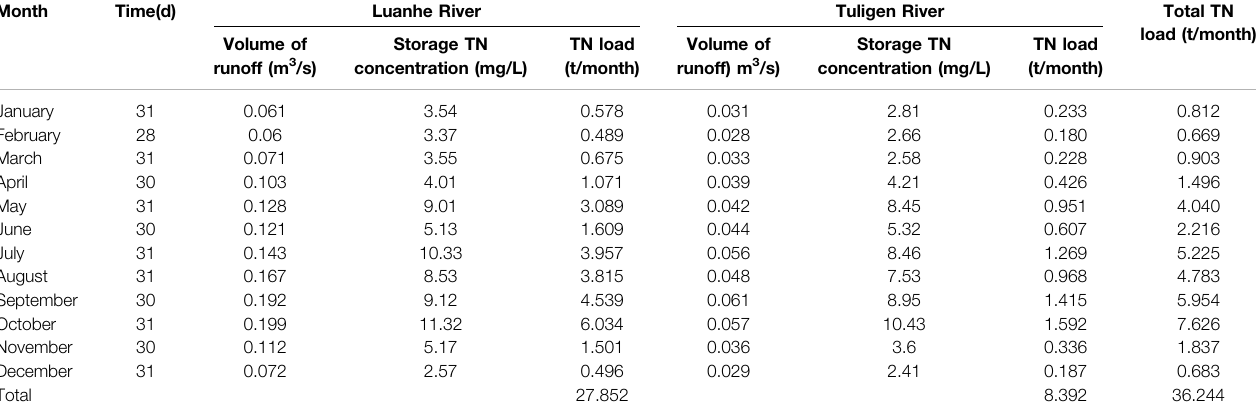
TABLE 4 | Estimations of the reservoir ’ s TN pollution load from runoff. Month